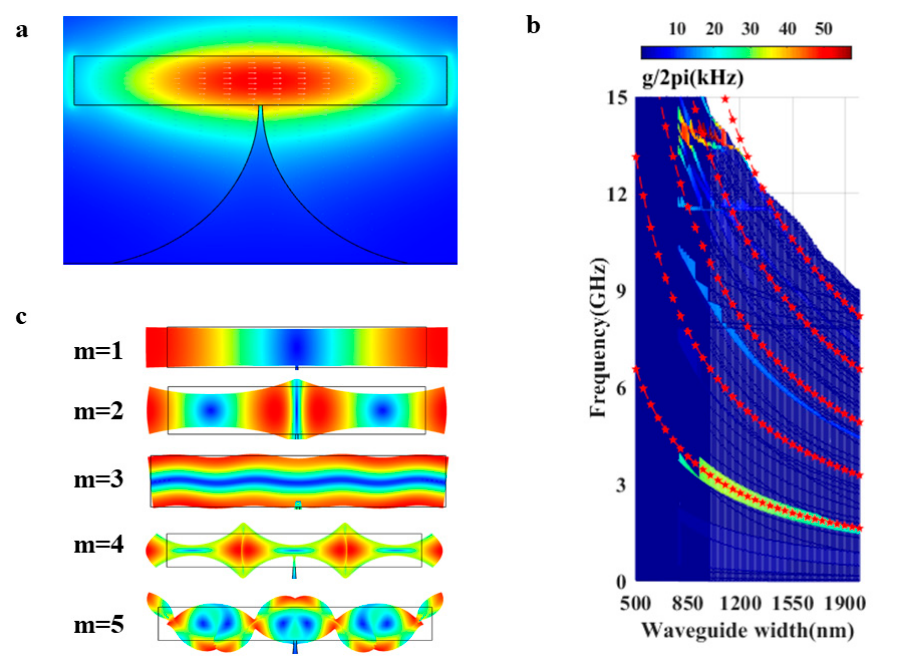
Figure 5. Based on forward Brillouin scattering: ( a ) the electric field distribution diagram of pump light, waveguide width w = 1.5 µm. ( b ) The finite element simulation of the photoacoustic coupling rate varies with the width of the waveguide in the suspended waveguide structure. The red dotted star line is the frequency calculated by satisfying the Fabry–Perot multi-order mode. The formula Ω p = mV l /(2 w) can be approximated for simulation, where V l = 6570 m/s. ( c ) When the waveguide width is 1.5 µm, the mode distribution diagram of the phonon mode determined in b that meets each phase-matching is determined.